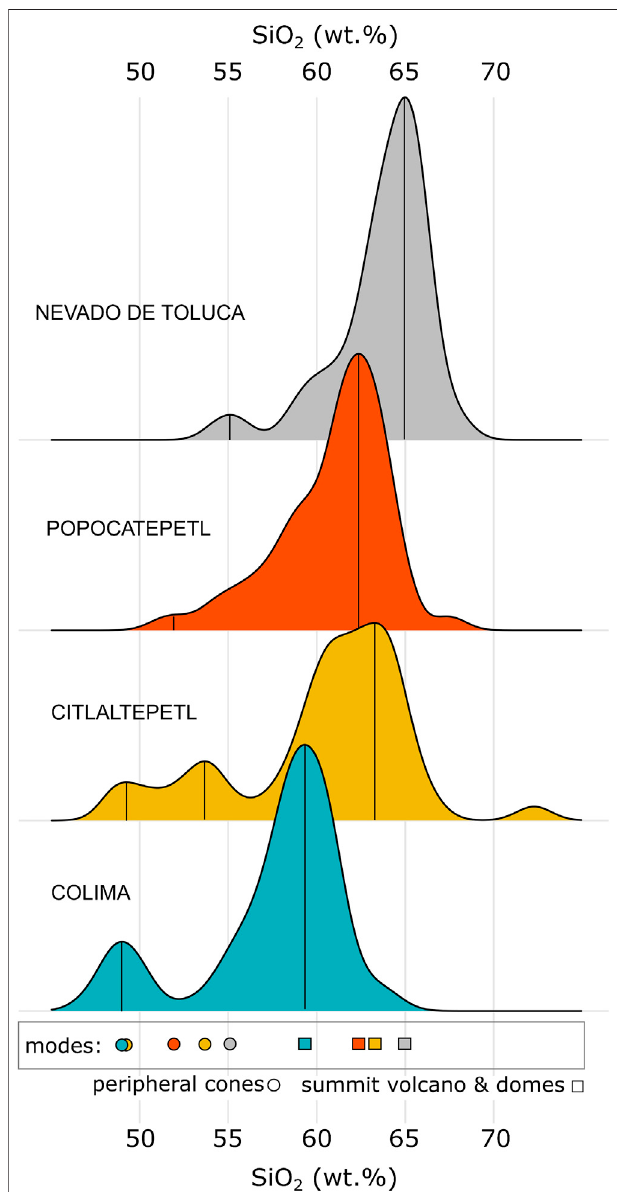
FIGURE 15 | SiO 2 (wt%) density distributions of whole-rock data from NevadodeToluca(gray),Popocatépetlvolcano(orange),Citlaltépetl( (cid:2) Picode Orizaba) (gold) and the Colima Volcanic Complex (cyan) with their peripheral cones. Data for Colima ( N (cid:2) 322 analysis), Popocatépetl ( N (cid:2) 220) and Citlaltépetl ( N (cid:2) 99) were minded from the GEOROC database (http://georoc. mpch-mainz.gwdg.de/georoc). Care was taken to exclude oversampling of prominent eruptions. Note that the position of the volcanos ’ mode and the composition of more ma fi c cones vary in concert.